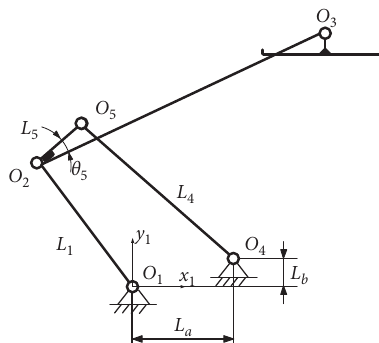
Figure 6: Simplified graph from Figure 4 to describe the constraint